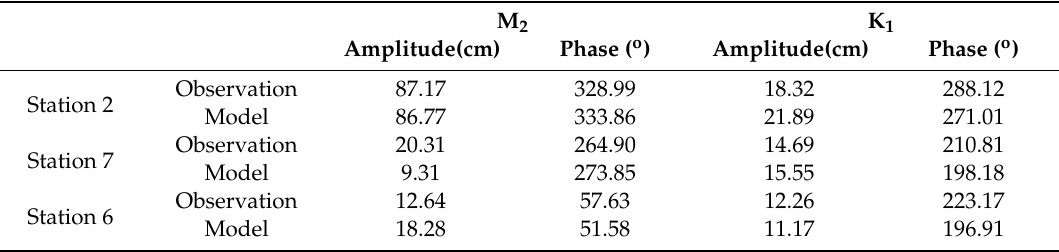
Table 1. Model-data validation of amplitudes and phases of the M2 and K1 tidal constituents at three gauge stations. The ROMS model results are based on the fully coupled case.